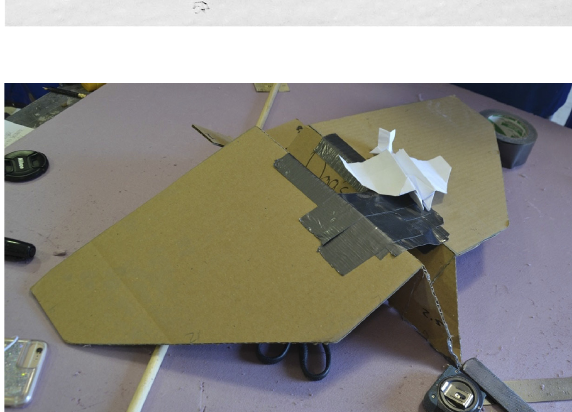
Figure 1. One middle school group ’ s plans for a